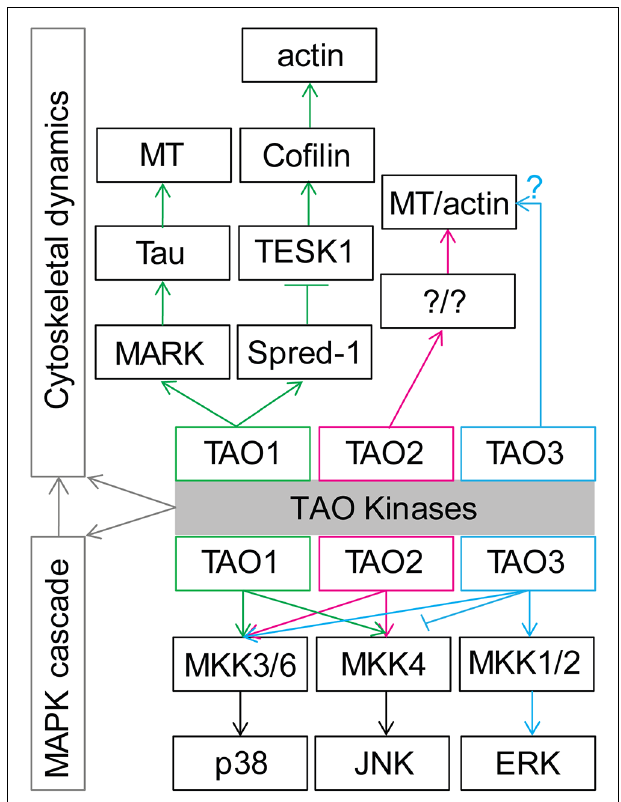
FIGURE 2 | General functions of TAO kinases in regulation of cytoskeletal dynamics and mitogen activated protein kinase (MAPK) cascade cytoskeletal dynamics. See the main text for details. Note that TAO1 and TAO2 share similar functions, although TAO1 preferentially activates p38 and TAO2 preferentially activates JNK. Importantly, the possible distinct function between TAO3 and TAO1/2 should be further